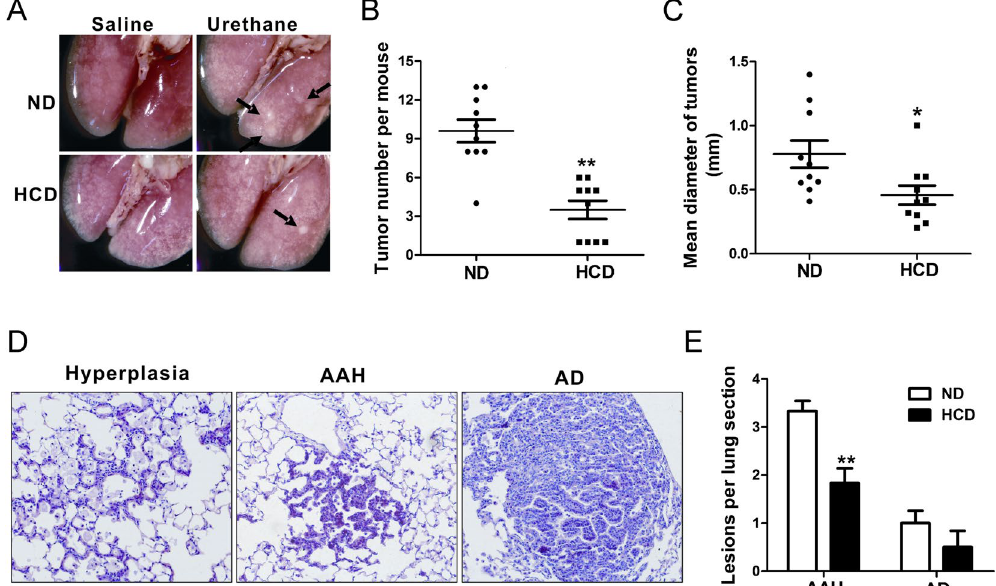
Figure 2. Decreased urethane induced lung tumor multiplicity and burden in HCD-fed C57BL/6J mice compared to ND-fed mice. Studies were carried out at experimental week 28, right after 15 weeks latency period. ( A ) Representative photographs of lungs under a dissecting microscope. Arrows point to visible lung tumors. ( B , C ) Tumor numbers and tumor diameters of urethane treated mice lungs (n = 10 mice per group). Dots indicate raw data points; lines, mean; bars, SEM. ( D ) Representative H&E staining of urethane treated mice lung sections, showing epithelial cell hyperplasia (Left), AAH (Middle) and AD (Right). ( E ) Numbers of different neoplastic lesion subtypes (AAH, AD) per mice (n = 6 per group). Columns, mean; bar, SEM. * P < 0.05, ** P < 0.01 compared to ND-fed mice. AAH: atypical adenomatous hyperplasia; AD: